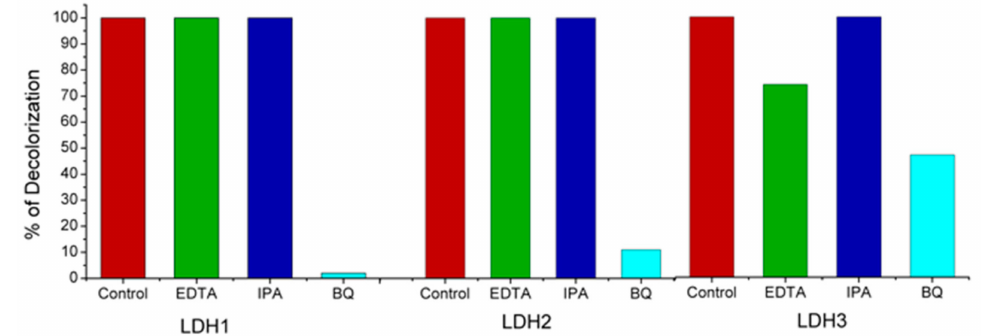
Figure 9. Photodegradation tests of RhB with di ff erent quenchers in the presence of the indicated